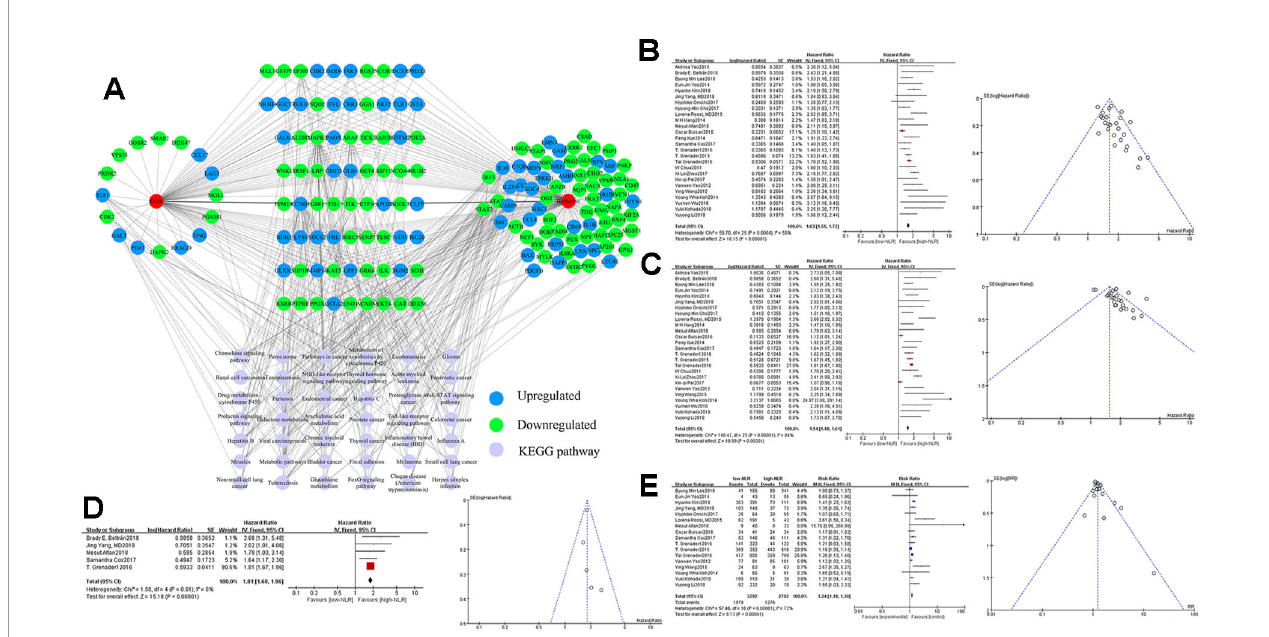
FIGURE 7 | The potential targets of DOX and berberine in regulating neutrophils analyzed by network pharmacology and a predictive role of neutrophil to lymphocyte ratio (NLR) in chemotherapy sensitivity of cancer patients. (A) The potential targets of DOX and berberine in regulating neutrophils. (B) Effect of NLR on progression-free survival (PFS) in cancer patients receiving chemotherapy in the meta-analysis shown as the forest map and the funnel diagram. (C) Effect of NLR on OS in cancer patients receiving chemotherapy in the meta-analysis shown as the forest map and the funnel diagram. (D) Effect of NLR on overall survival (OS) in cancer patients receiving combination chemotherapy in the meta-analysis shown as the forest map and the funnel diagram. (E) Effect of NLR on adverse effects in cancer patients receiving chemotherapy in the meta-analysis shown as the forest map and the funnel diagram. DOX,